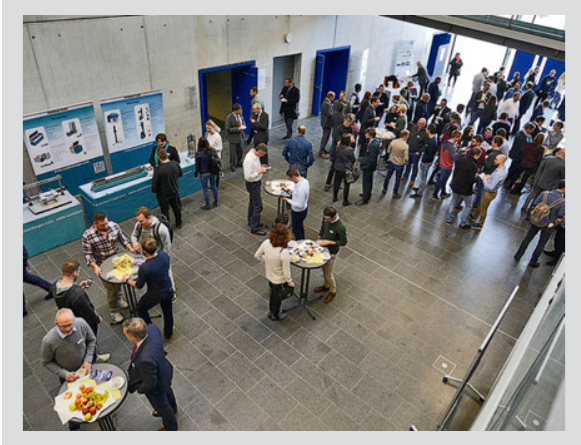
discussions.Figure 1: Participants during the presentations of the 27 th con-